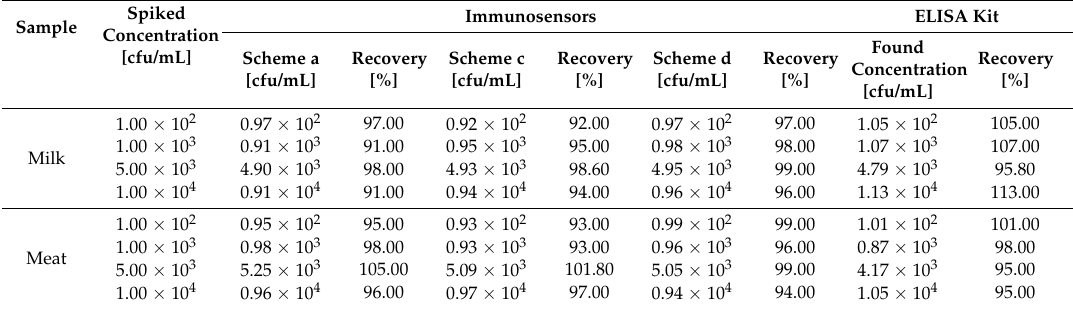
Table 2. E. coli results in spiked milk and meat samples obtained by impedimetric immunosensors and ELISA